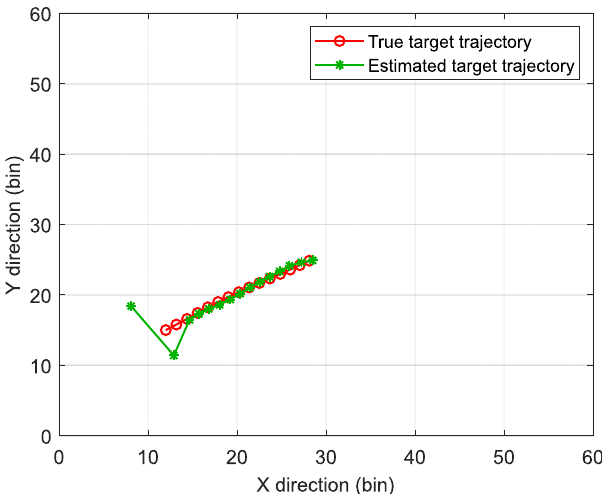
Figure 6. The estimation results of the proposed